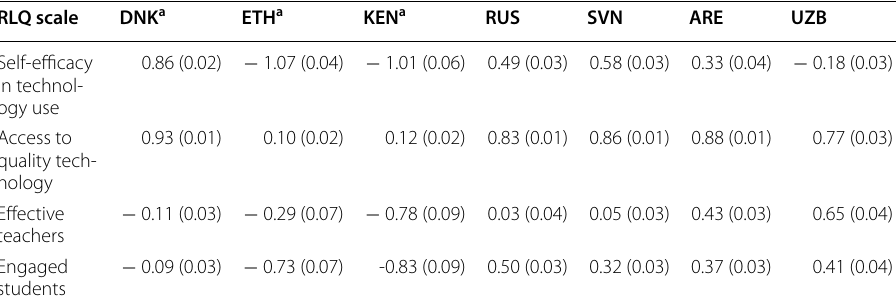
Table 2 Average remote learning quality scales and indicator by country